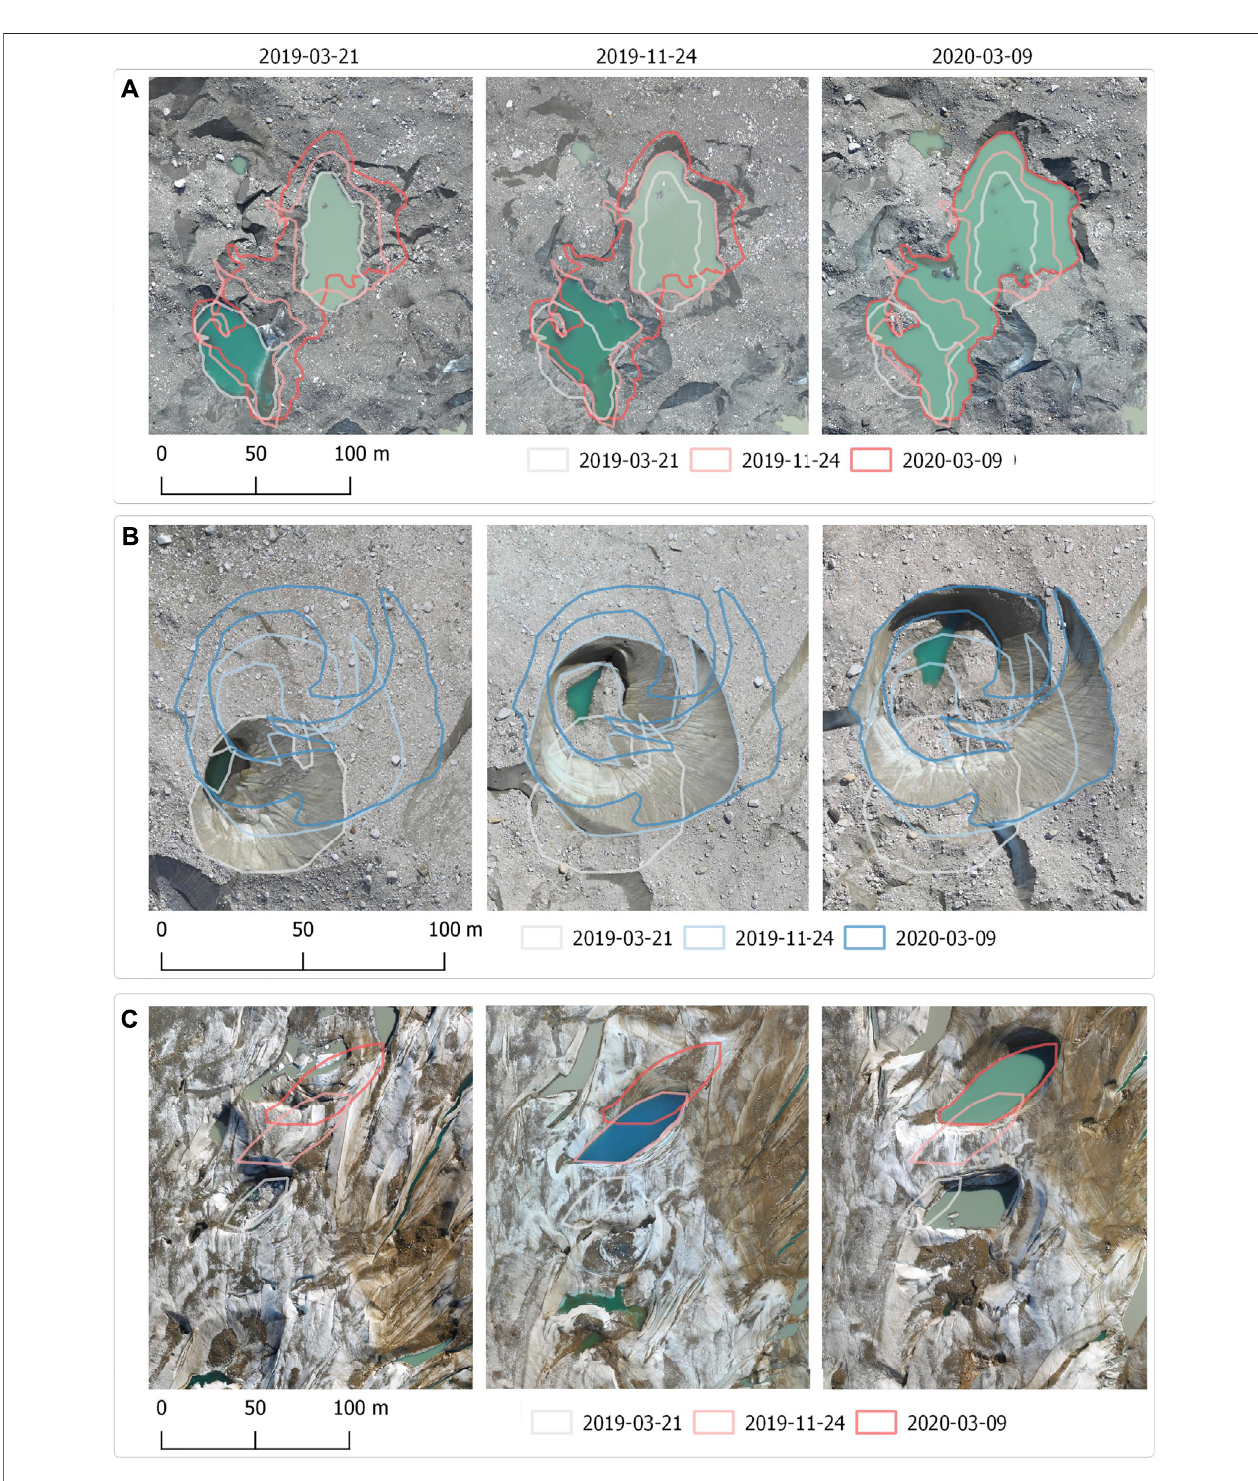
FIGURE 6 | (A) Supraglacial pond coalescence by ice-cliff backwasting. (B) Thermo-karst sink hole and ice-cliff backwasting. (C) En-echelon crevasses and supraglacial pond formation. Location of the ponds is provided in Figure 2B .